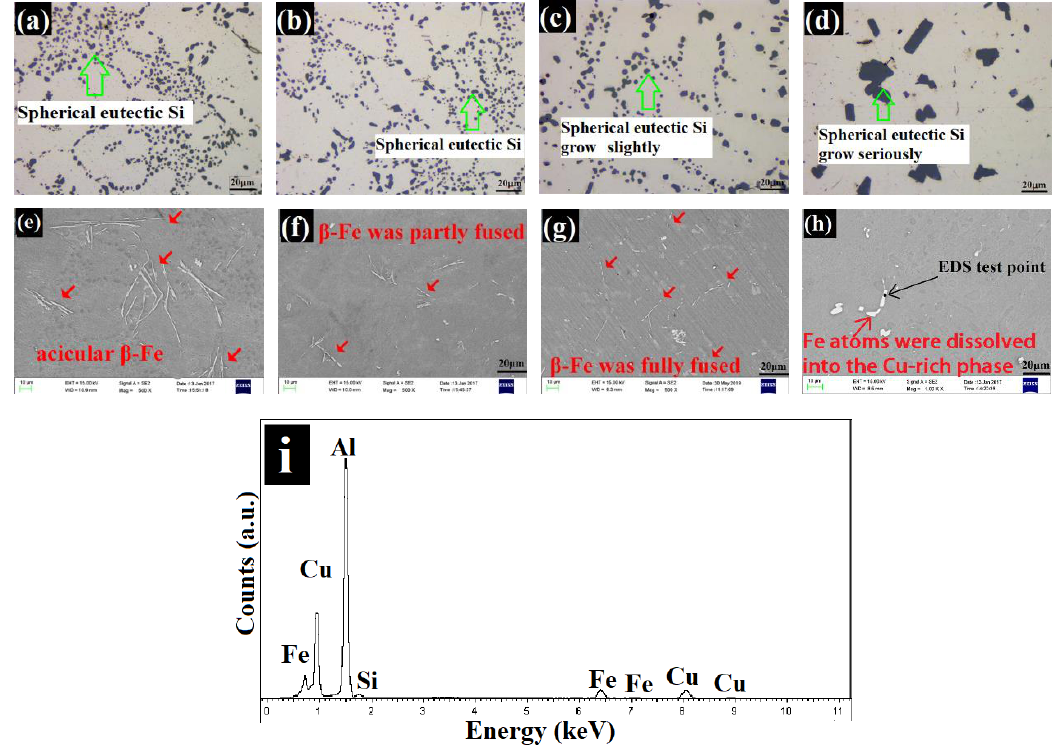
Figure 5. The morphology of the eutectic Si by OM and the size and texture of Fe-rich phases, determined by SEM, of Al9Si1.2Cu0.4Mg (0 wt%–0.9 wt% Zn) in the heat treatment: ( a,e ) free-Zn, ( b,d,f ) 0.3 wt% Zn, ( c,g ) 0.6 wt% Zn, ( d,h ) 0.9 wt% Zn, ( i ) EDS detection of ( h ).